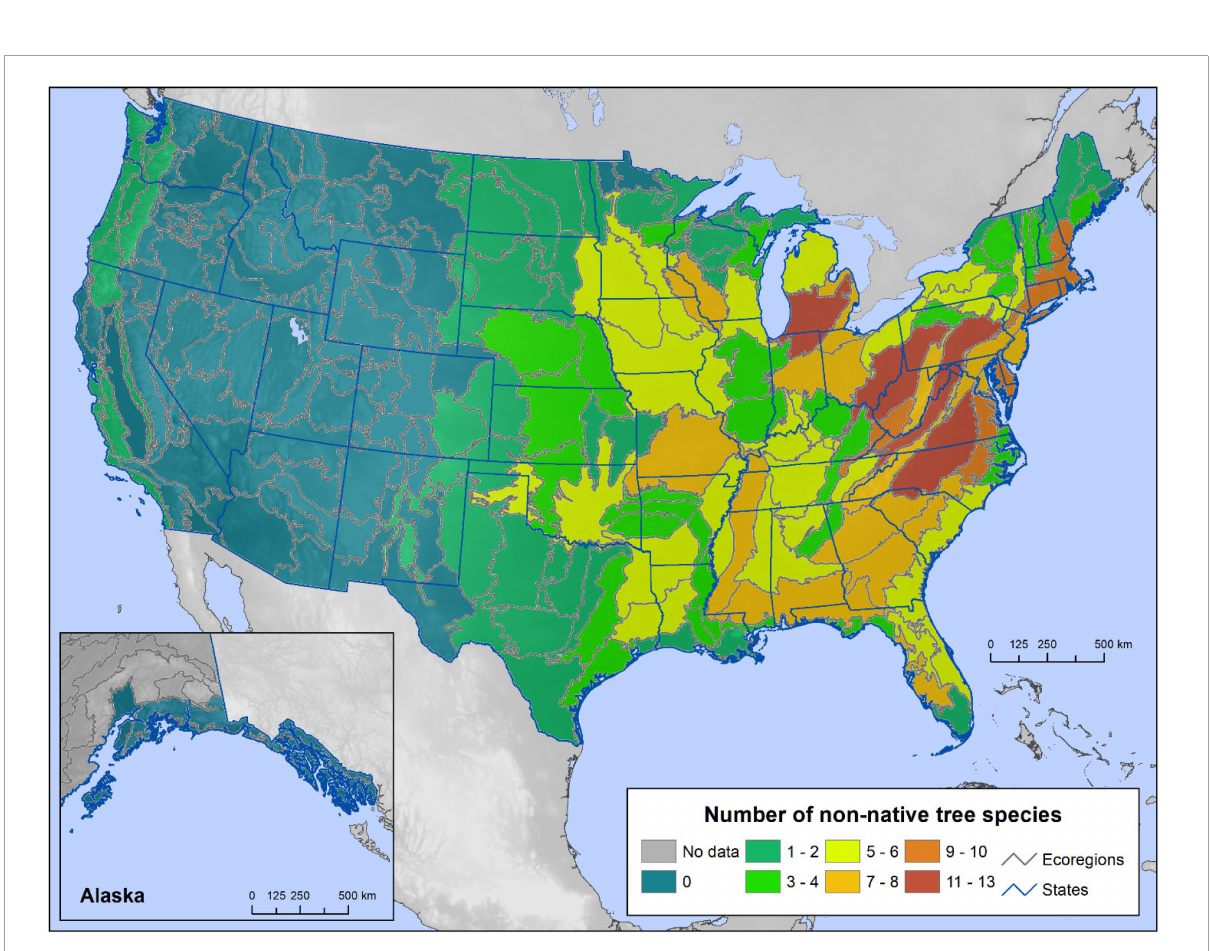
FIGURE2 The number of non-native tree species present in each ecoregion section of the conterminous United States and coastal southeastern Alaska using Forest Inventory and Analysis (FIA) tree occurrence data.